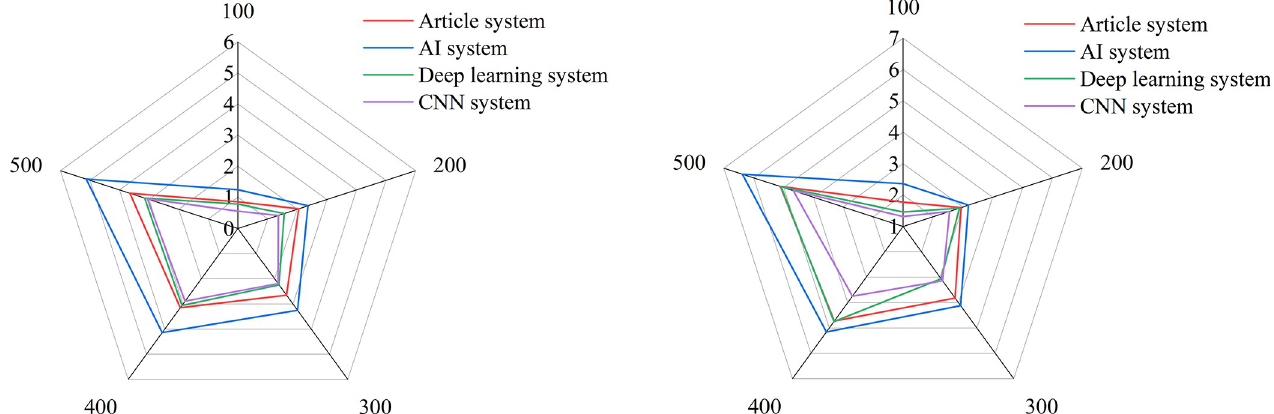
Fig 15. The response times of different smart classroom